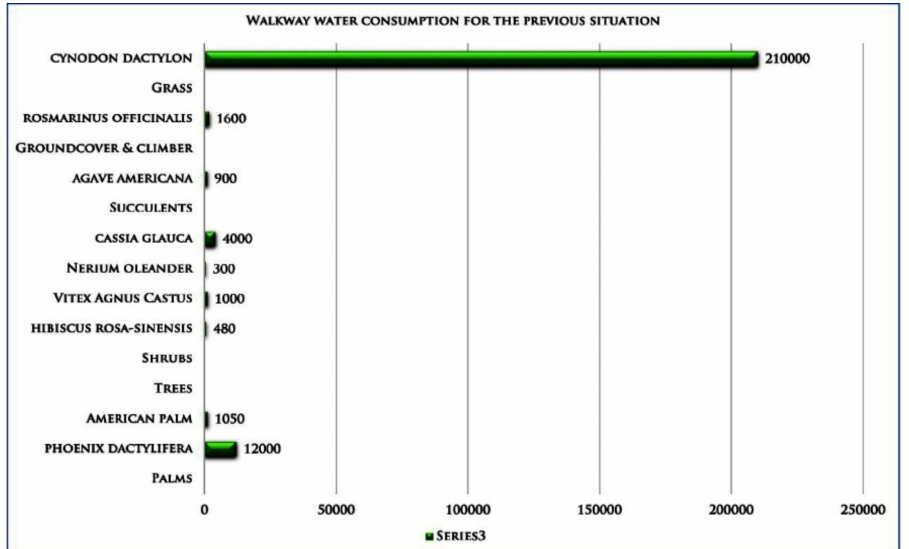
Figure 19. Experiment 4, water consumption quantity for the previous status. Previous Tender softscape design water consumption (Details in Table A4).